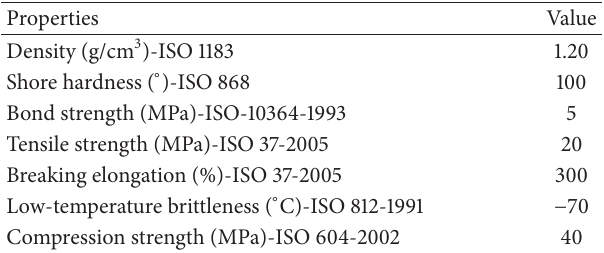
Table 1: Physical and mechanical properties of the polyurethane